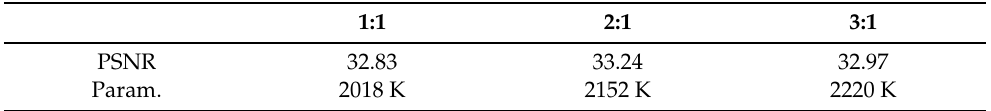
Table 4. Effects of different super-parameter of M and N . We report the best average PSNR(dB) on Set14 (×2) in 2.5 × 10 4 iterations.